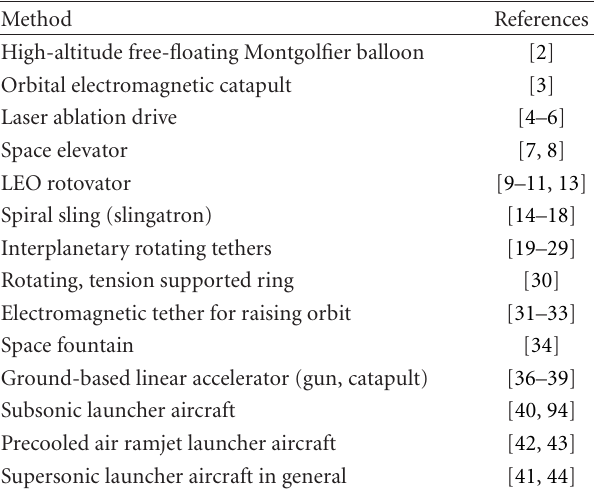
Table 1: Previously proposed launch assistance